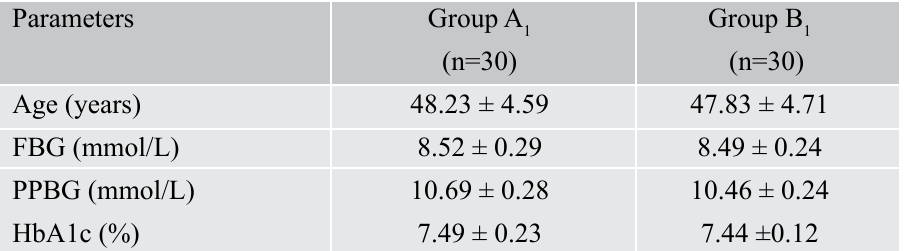
Table I: Age, fasting blood glucose (FBG), PPBG and HbA1c% in